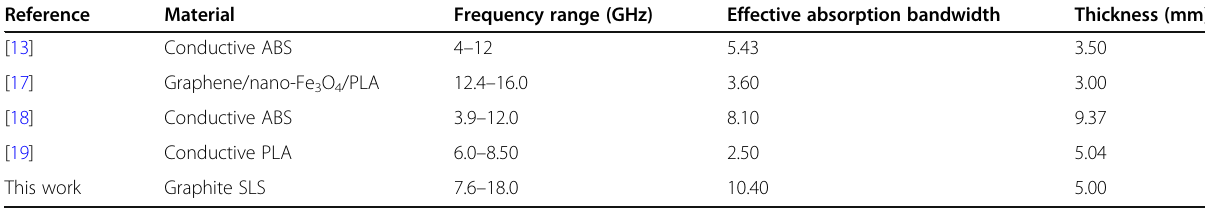
Table 1 Comparison of − 10 dB absorption bandwidth range between radar-absorbing metastructure of this work and previous works